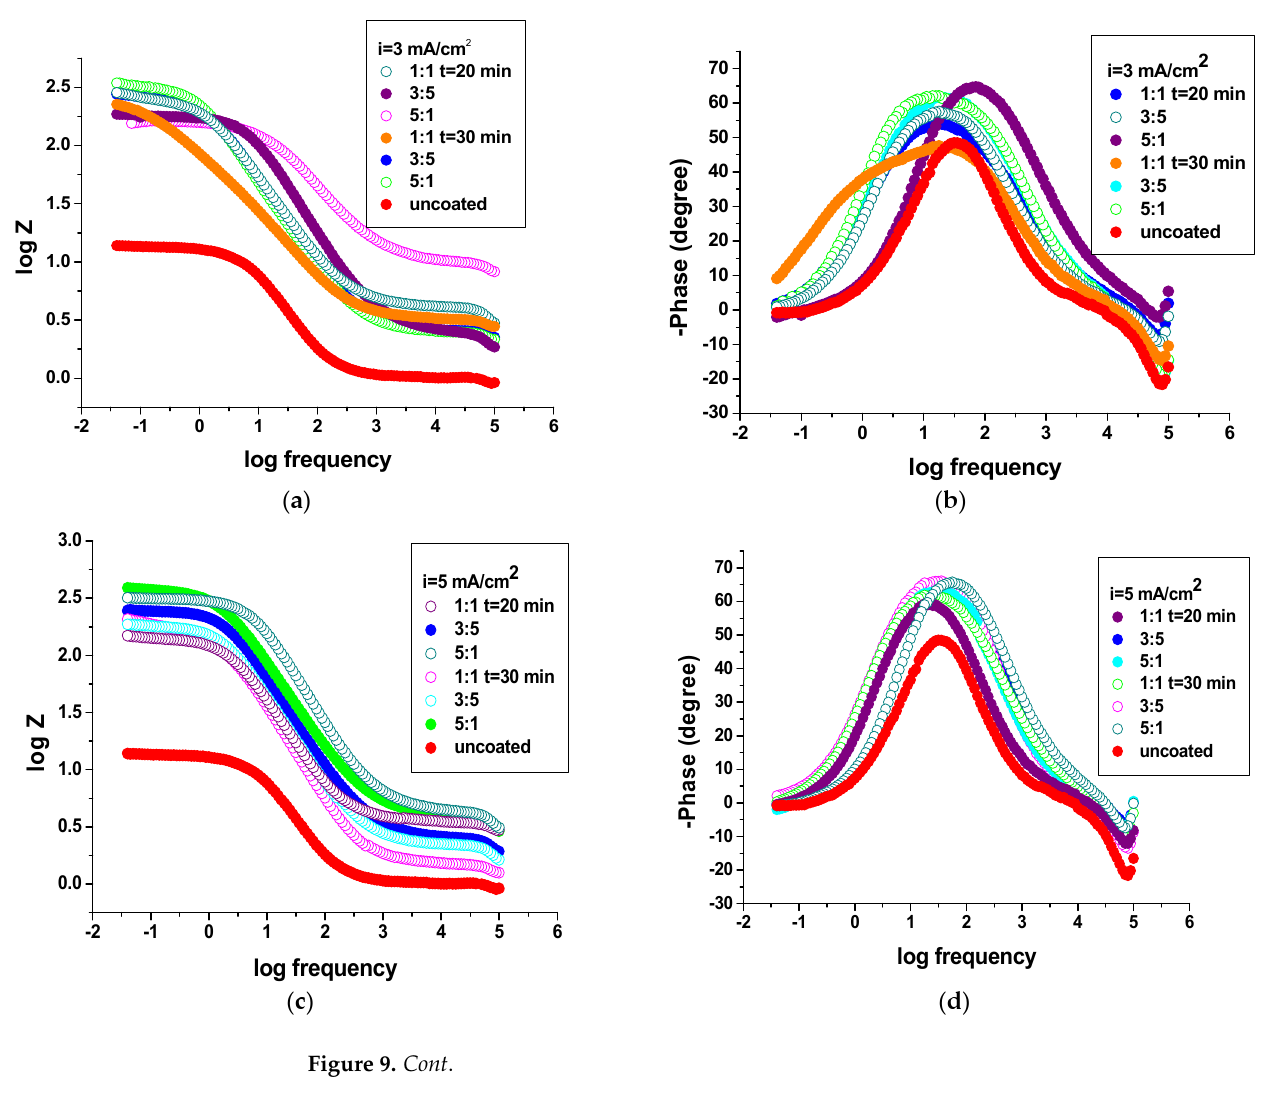
( h ) Figure 9. Bode diagrams for uncoated and PNMPY-TW20/P3MT-coated OLC 45 sample by gal- vanostatic, at ( a , b ) 3 mA/cm 2 and ( c , d ) 5 mA/cm 2 current density, and potentiostatic, at 1.2 V ( e , f ) and 1.4 V ( g , h ) potential, procedures with diverse molar ratio for PNMPY-TW20 and P3MT.